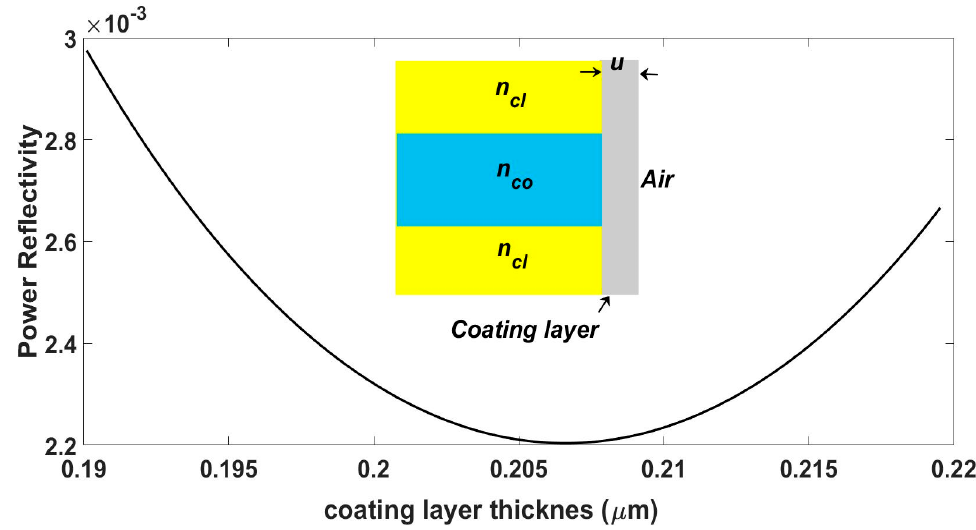
Figure 3. Power reflectivity of single layer antireflection coating as function of coating thickness u . The minimum at u = 0.206 µm agrees with accurate previously published results.